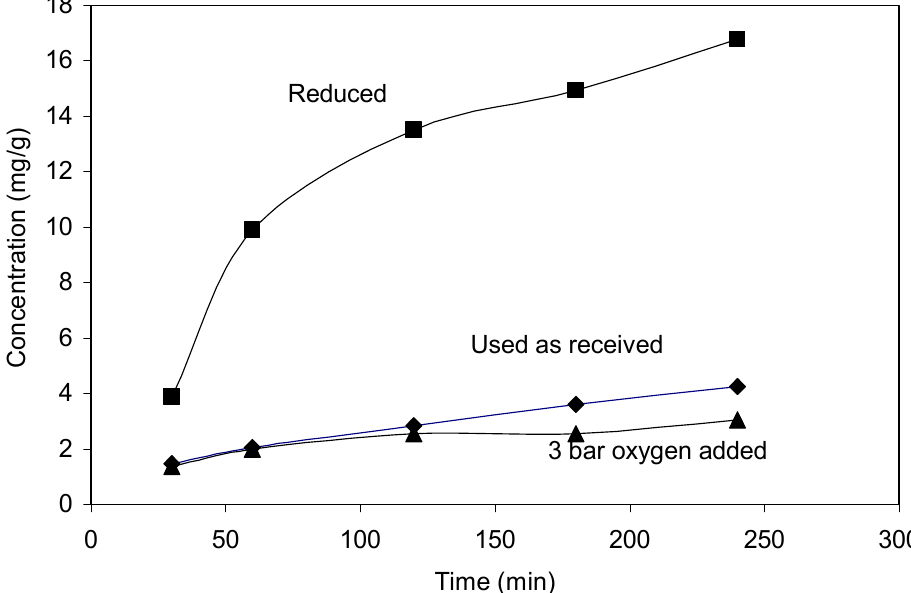
Figure 9. Effect of catalyst pretreatment on diethyl ether formation over a Ni catalyst (HTC-500) in the bath reactor. Reaction conditions: 250 °C, 70